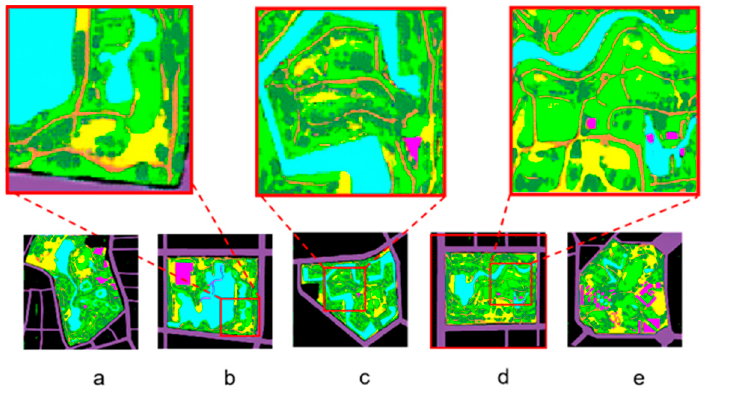
Figure 14. Analysis of elemental footprint. (b) The position relationship between the various elements is reasonable (Figure